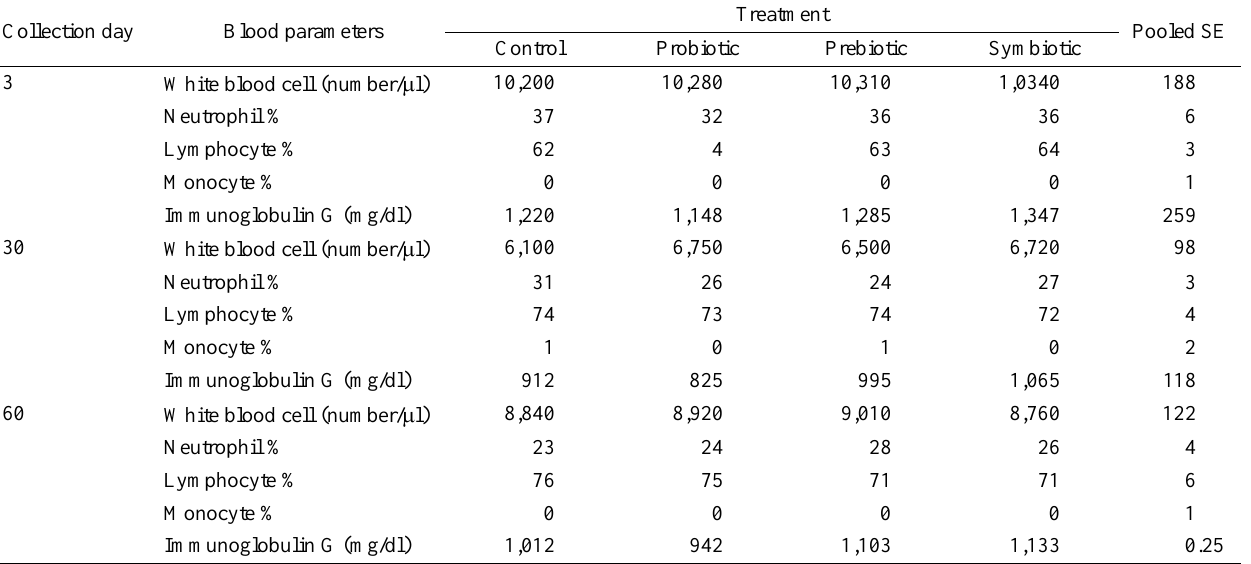
Table 5. Blood parameters in calves fed with or without additives Collection day